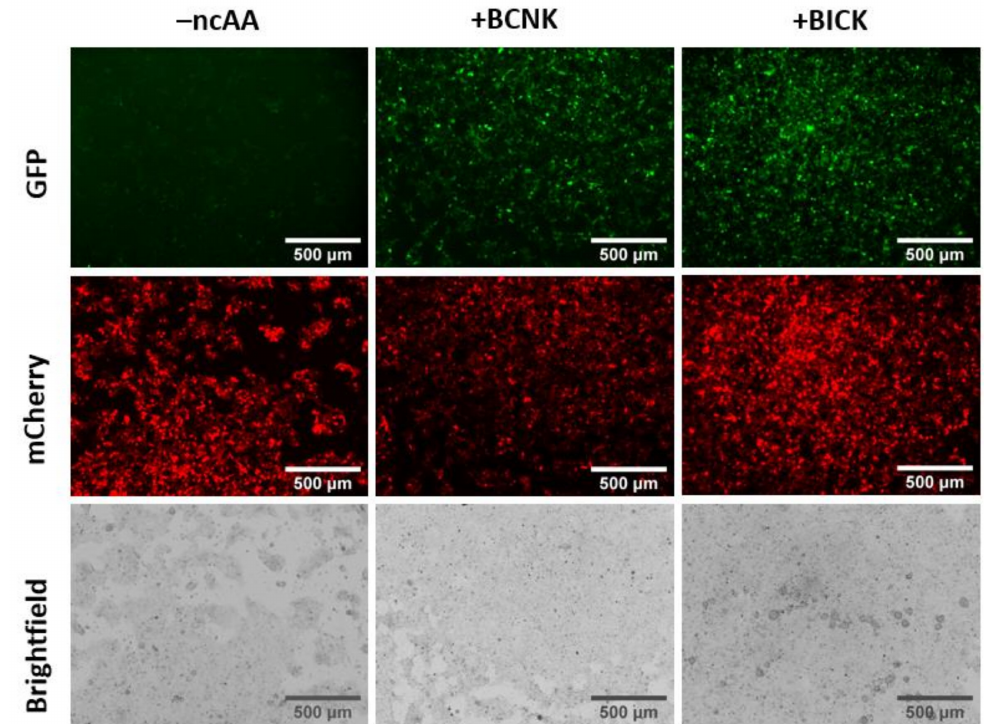
Figure 2. Live cell fluorescent wide field imaging of specific incorporation of 250 µ M BCNK ( middle column ) and 1 mM BICK ( right column ) into pmCherry-TAG-EGFP in HEK293T cells. mCherry-positive cells were successfully transfected with the plasmid bearing the POI, while the amber STOP codon is suppressed only in GFP-positive cells by a site-specific incorporation of the added ncAAs. Scale bar = 500 µ